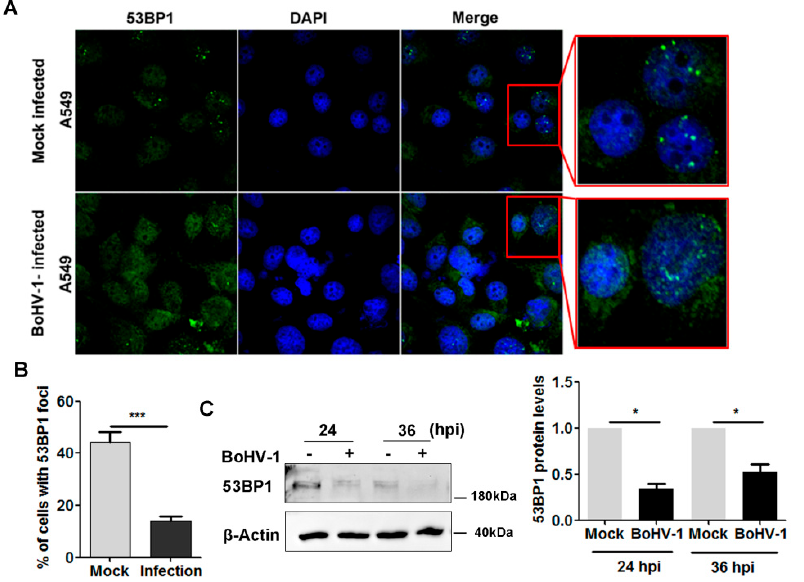
Figure 3. Effects of BoHV-1 infection on 53BP1 expression and foci formation. ( A ) A549 cells were either mock-infected or infected with BoHV-1 at an MOI of 0.1 for 24 h. The cells were fixed with 4% formaldehyde, and 53BP1 was detected by IFA. Nuclei were stained with DAPI. Images were obtained by confocal microscopy (magnification ×600 with 2.5 zoom). ( B ) Approximately 600 cells were counted to calculate the percentage of cells with 53BP1 foci. Error bars denote the variability between the three independent experiments. Significance was assessed with Student’s t -test (*** p < 0.001). ( C ) After virus infection for 24 h as described in panel A, the cell lysates were prepared for Western blot analysis to detect 53BP1 and β -Actin. The band intensity of 53BP1 was initially normalized to β -Actin, and the fold change after virus infection was calculated by comparison to the uninfected control that was arbitrarily set as 1. Images represent data from three independent experiments. Data shown in the right panel are the means ± SD of the three independent experiments.